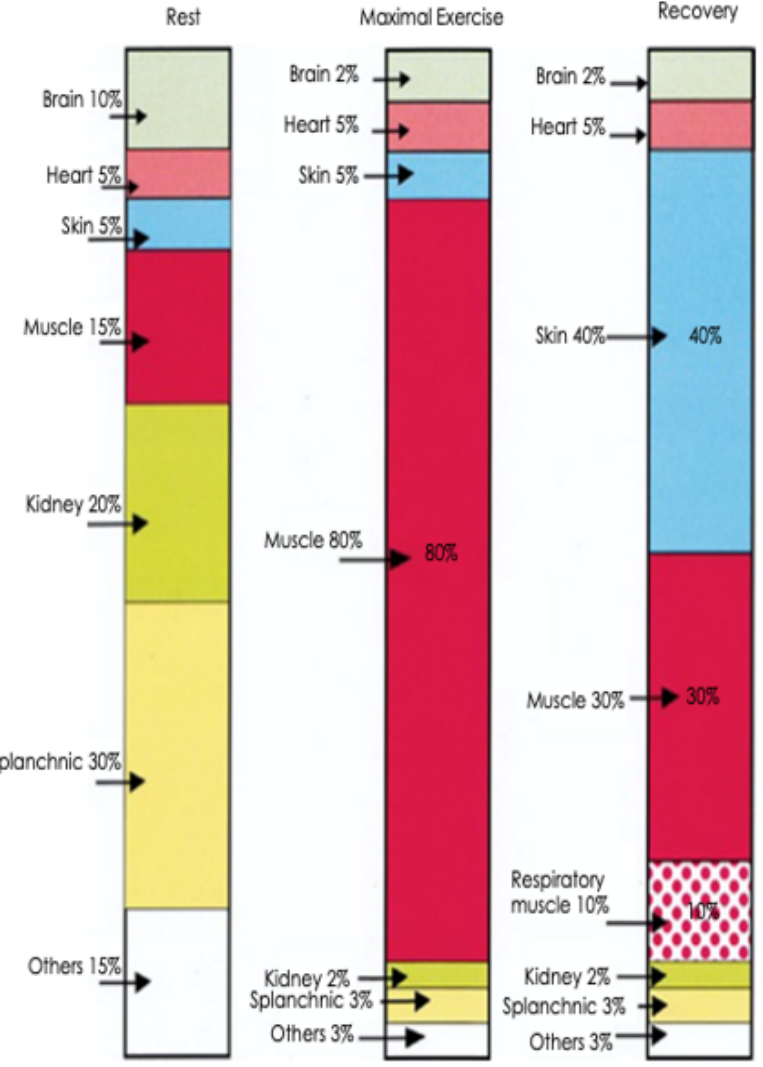
Figure 5. Distribution of cardiac output at rest, during maximum exercise and into the recovery period. During strenuous exercise it is highly likely that muscle blood flow may reach 80% of cardiac output, whilst skin blood flow will diminish to only 5%. Also note the substantial reductions in splanchnic